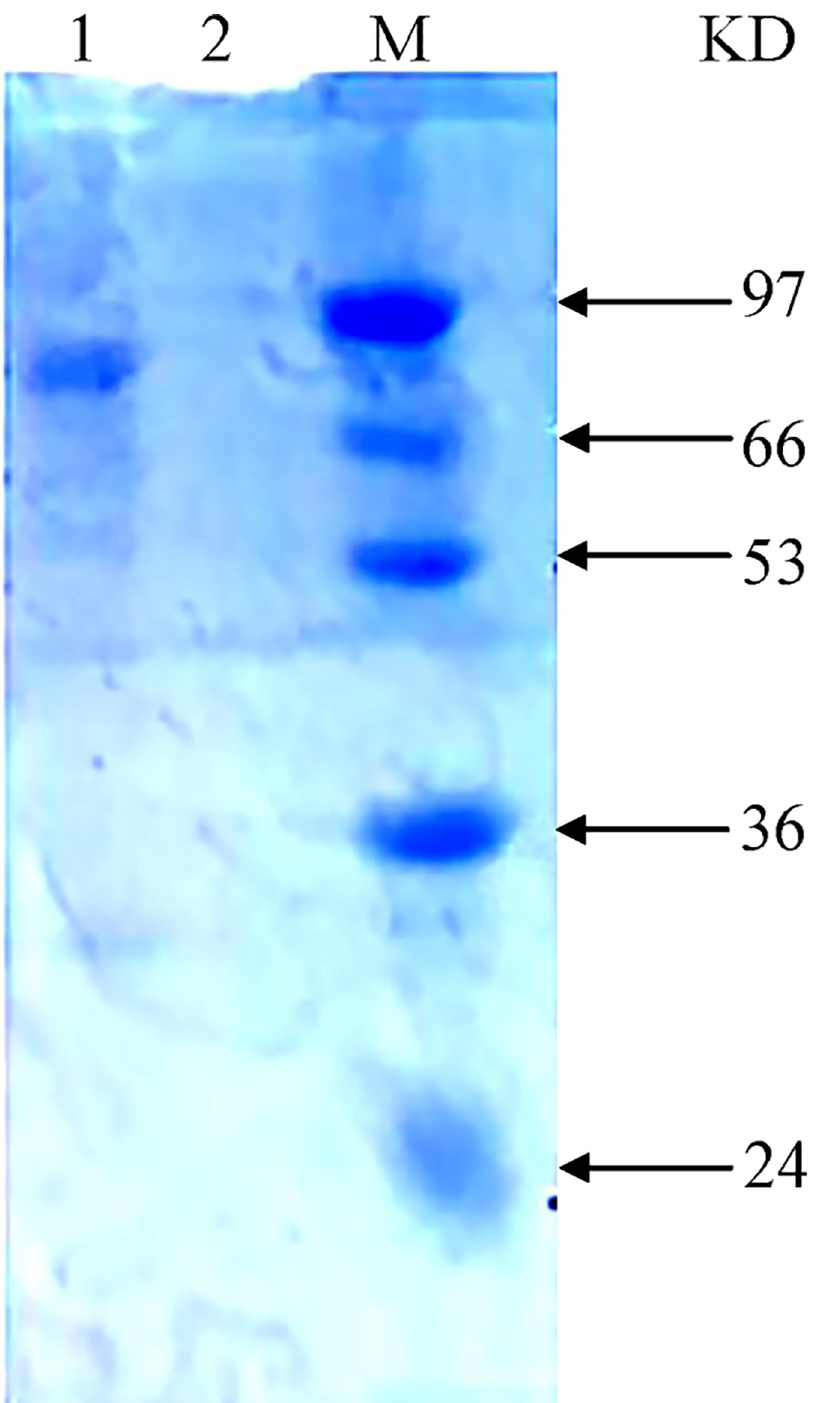
Fig 2. SDS-PAGE detection of heterologously expressed AglB purified with affinity chromatography. (M, Marker; lane 1, purified AglB protein; lane 2, control).